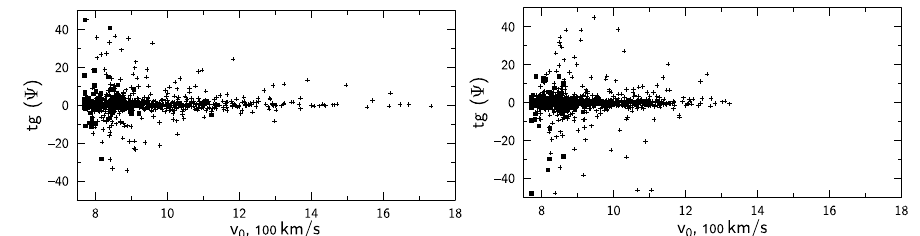
Fig. 2. The angle between the initial velocity vector and the semimajor axis of the bar versus the initial velocity v 0 of the star, in the units of 100 km s − 1 , for simulations with the semimajor axis of a binary system equal to 282 R ⊙ and the pericentric distances 10 000 R ⊙ (the left panel) and 15 000 R ⊙ (the right panel). The pluses and squares denote the hypervelocity and non-escaping stars,